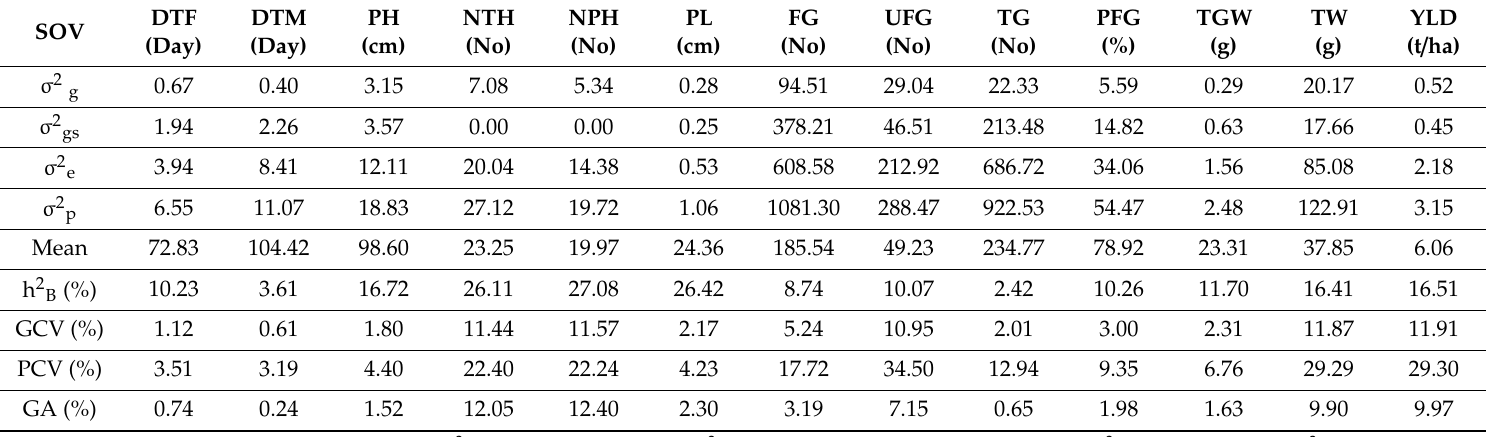
Table 4. Variance components, coe ffi cients of variation, heritability and genetic advance of the rice genotypes for 13 traits assessed in four